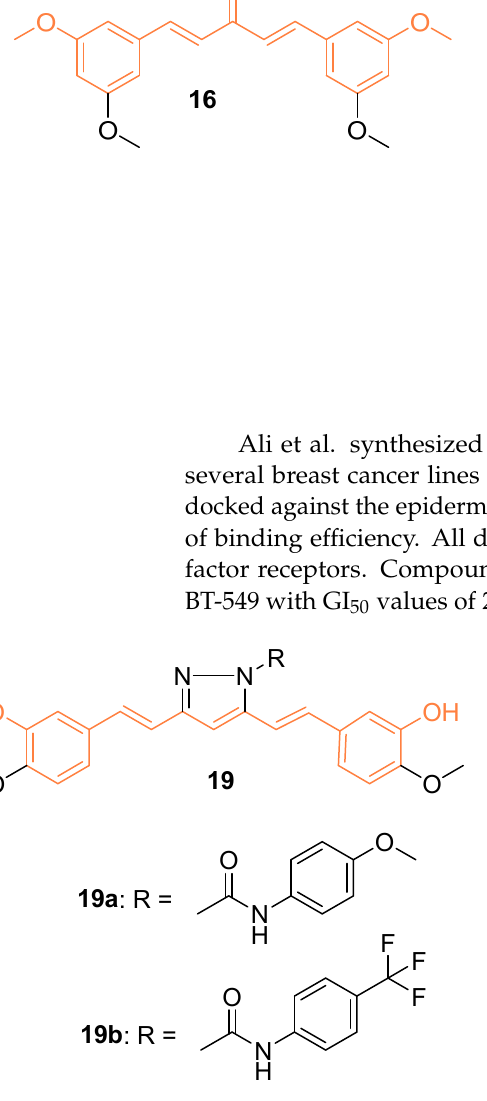
Table 1. Summarized information on curcumin analogs.